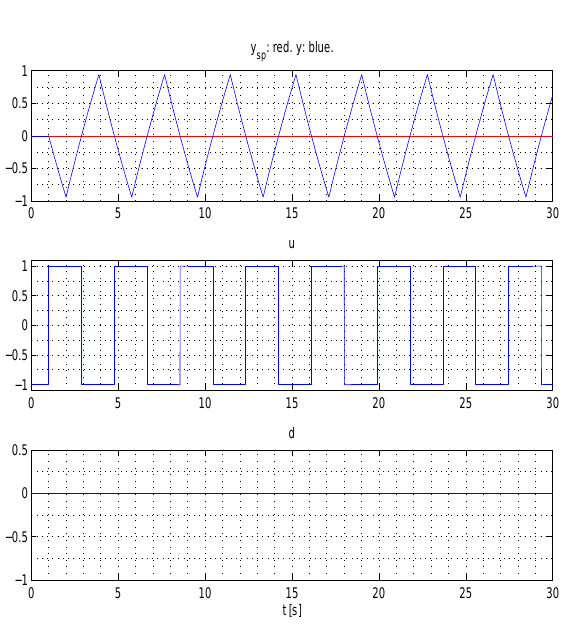
Figure 4: Responses during relay tuning Various PI settings are calculated from the above values of K c and P u using the formulas in Table 1. u